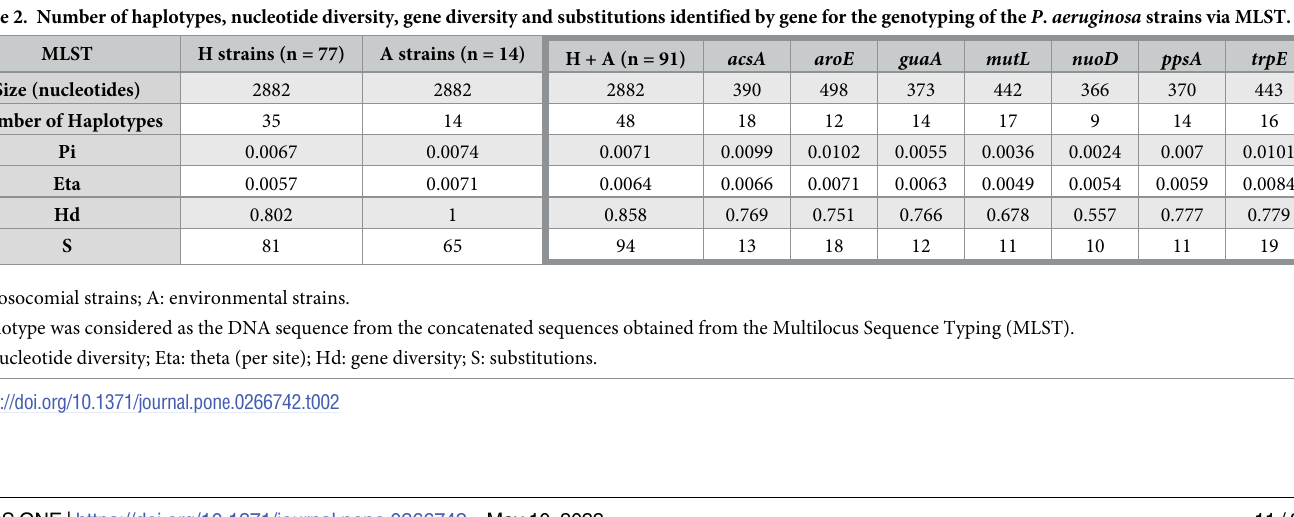
The ST for 58 P . aeruginosa strains were acquired from the PubMLST data base entry http:// pubmlst.org/paeruginosa/ (S1 Table), being the endemic clone ST1725 the most frequent and persistent for over 7 years in the hospital. The remaining 33 strains isolated during 2013–2015 were analyzed here, revealing three new alleles: allele 233 for aroE , 147 for guaA , and 157 for mutL; in addition to 23 new ST that were integrated into the worldwide P . aeruginosa MLST database (S1 Table). During the same period, six ST233 strains and one ST111 strain (both reported worldwide as high-risk clones) were isolated, with ST111 identified in the environ- ment. Of the 48 ST studied, the environmental strains showed the greatest diversity, with a dif- ferent ST in each strain (Table 1). The nucleotide and gene diversity were greatest among environmental strains (Pi, 0.0074; Hd, 0.0071), with the greatest diversity observed in the aroE and trpE genes (Pi, 0.010; Hd, 0.007). Of the 94 SNPs identified, 81 were in hospital strains, with the greatest number seen in the aroE (n = 18) and trpE (n = 19) genes. Relevant genetic data, including the number of haplotypes, nucleotide diversity, gene diversity, and substitu- tions identified by MLST genotyping are summarized in Table 2.